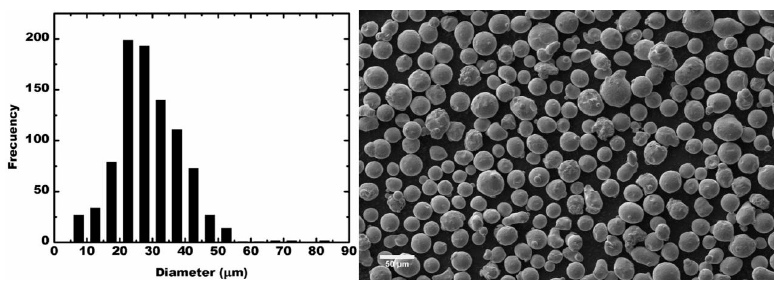
Figure 3. Particles distribution.